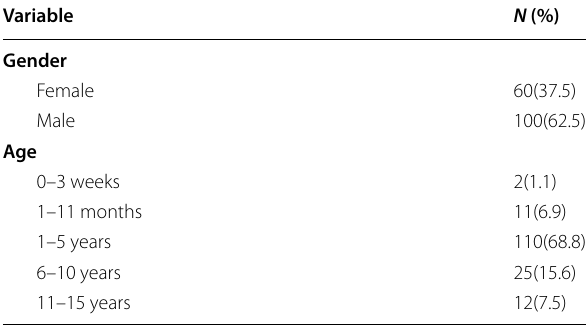
Table 1 Socio-demographic characteristics of